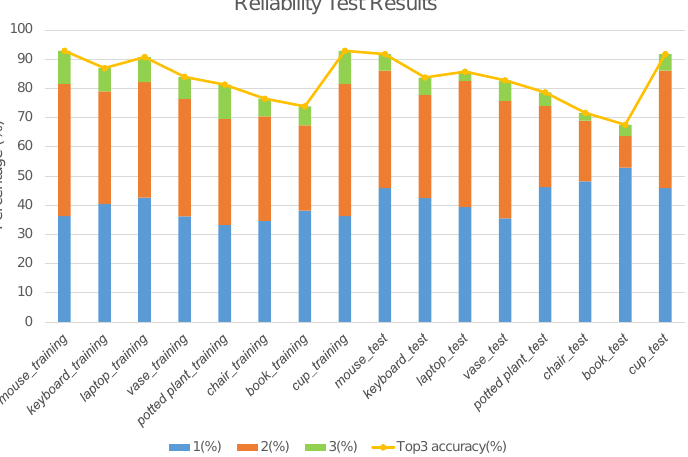
Figure 7. Reliability test results of the semantic association model for the office places.